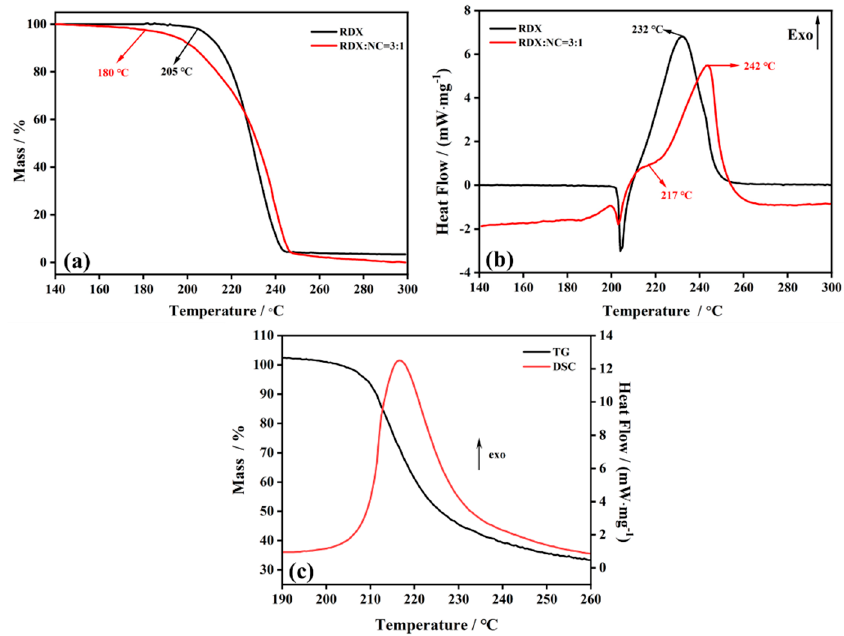
Figure 8. TGA/DSC of RDX@NC microspheres at 10 K/min: ( a ) TG curves of raw RDX and RDX@NC; ( b ) DSC curves of raw RDX and RDX@NC; and ( c ) TG-DSC curves of NC.